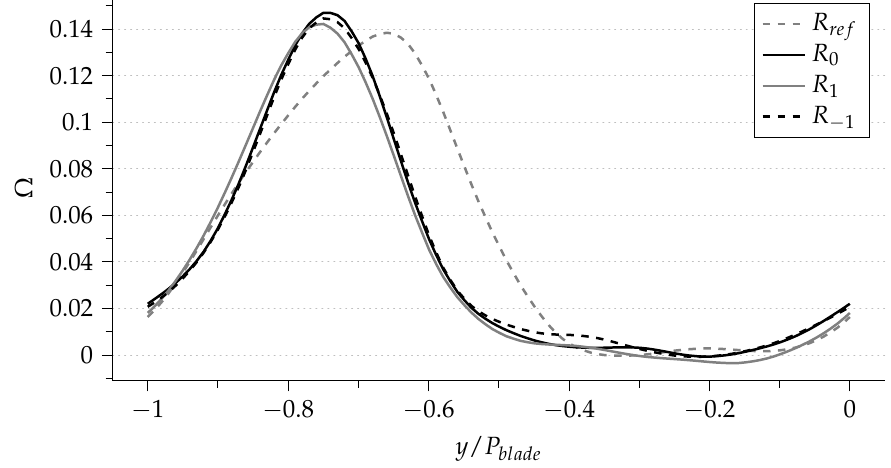
Figure 7. Time-averaged total pressure loss profile Ω extracted at ‘Measurement Plane 2’ (1.26 c ) for cases R ref (no bars), R 1 (counter-clockwise), R 0 (non-rotating) and R − 1